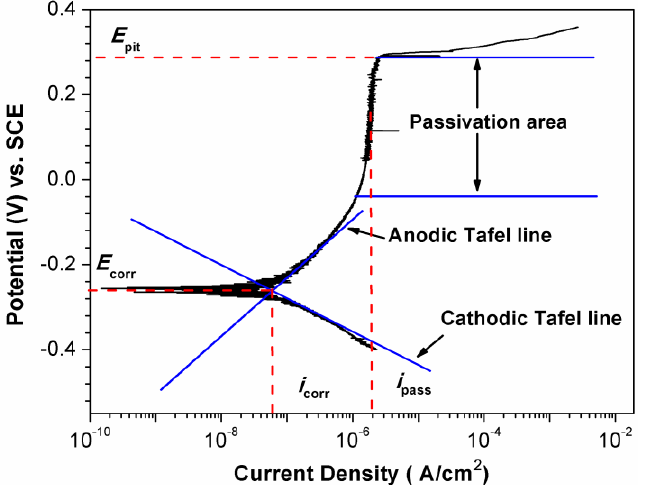
Figure 1. A typical potentiodynamic-polarization curve for the explanation of the parameters. E corr , corrosion potential; i corr , corrosion current density; Passivation area, the potential range where a protective oxide film formed to prevent the continual metal from dissolving; E pit , critical pitting potential; i pass , current density in the passivation area.